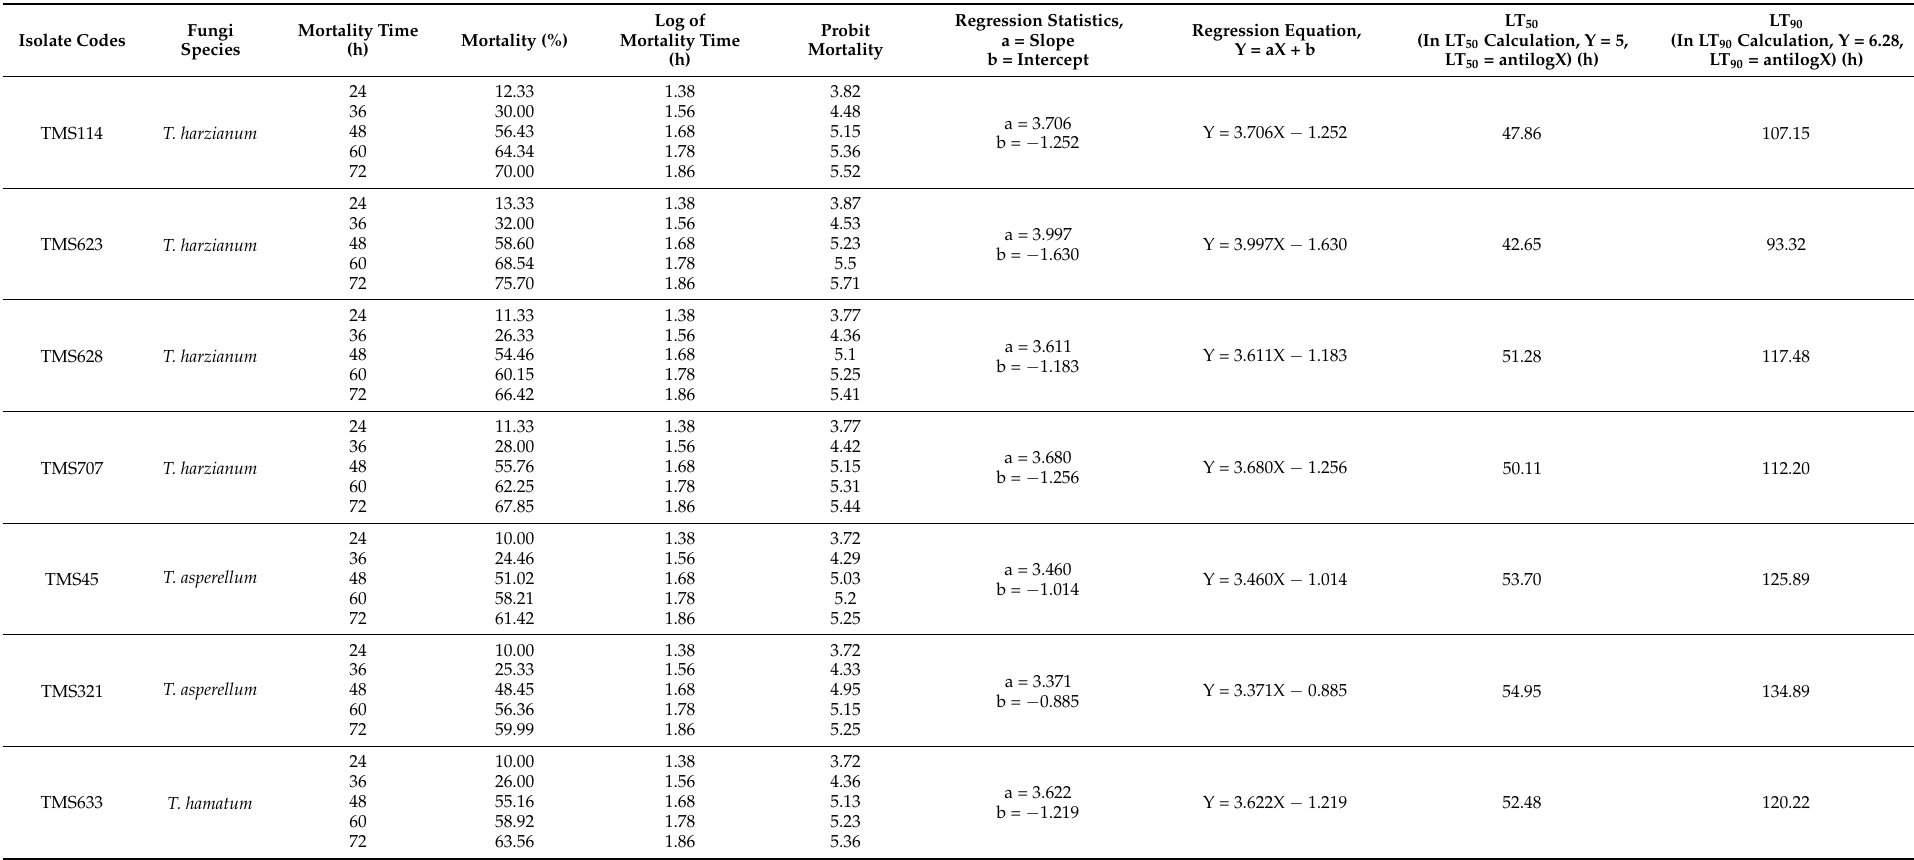
Table 4. LT 50 & LT 90 values for the efficacy of isolates against nymphs using mortality of different times (24 to 72 h) at 1 × 10 8 conidia mL − 1